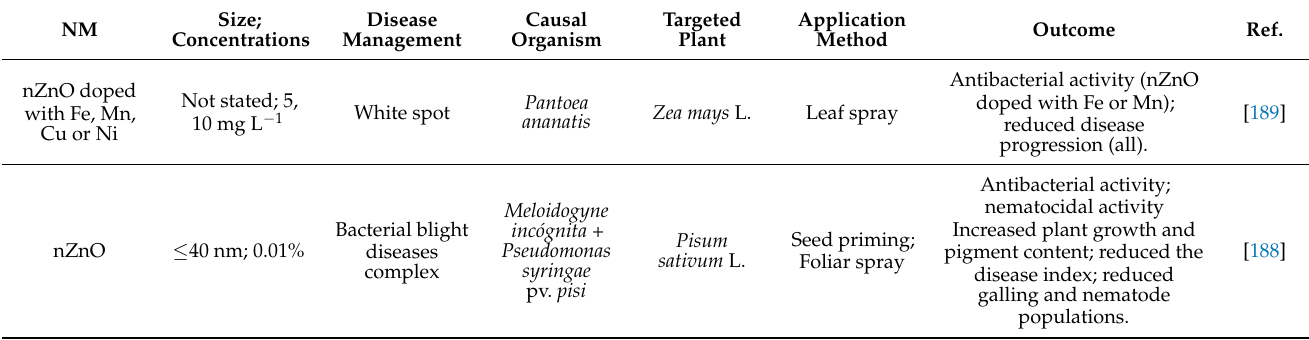
Table 9. Beneficial application of nZnO on plant diseases